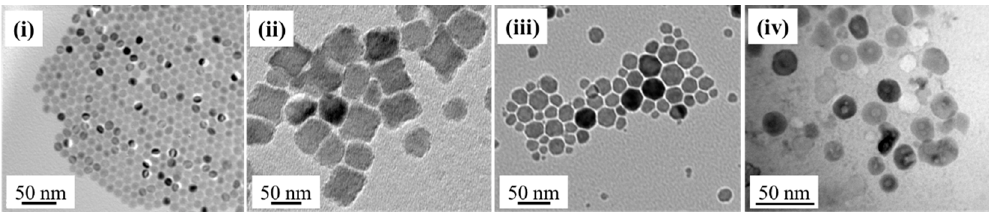
Figure 5 . TEM images of the Fe 1- x Mn x O nanoparticles with different composition ratio. ( i )–( iv ) are as indicated in Table 1 that corresponds to different x in composition.